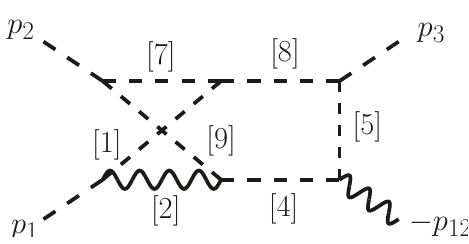
Figure 4 . The diagram corresponding to I np2 sive) propagators and [ n ] corresponds to the ordering in eq.